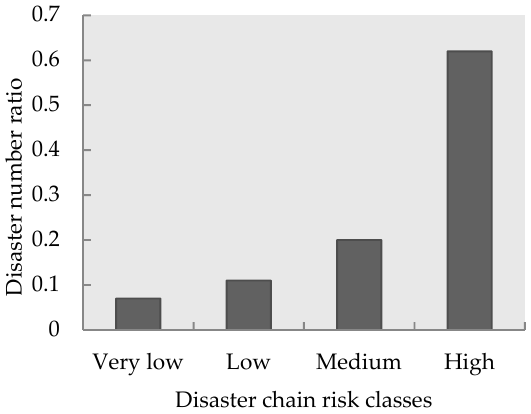
Figure 7. The relative distribution between the disaster chain risk zones and disaster number ratio.